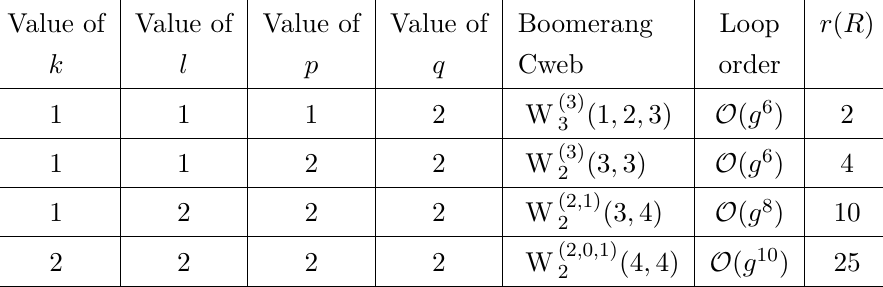
Table 8. Cwebs of this class present at different